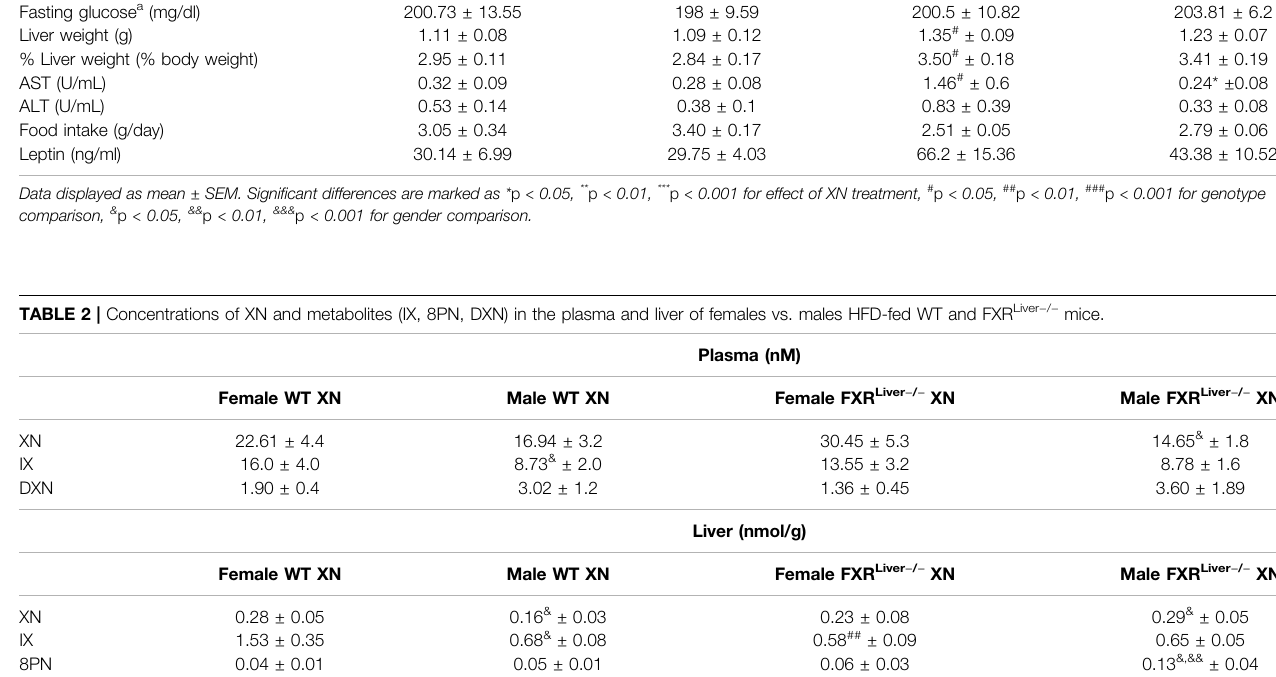
TABLE 1 | A list of metabolic parameters measured in WT and FXR Liver − / − mice upon 10 weeks ( a ) or 12 ° weeks of HFD ± XN. WT WT XN Initial body weight (g)